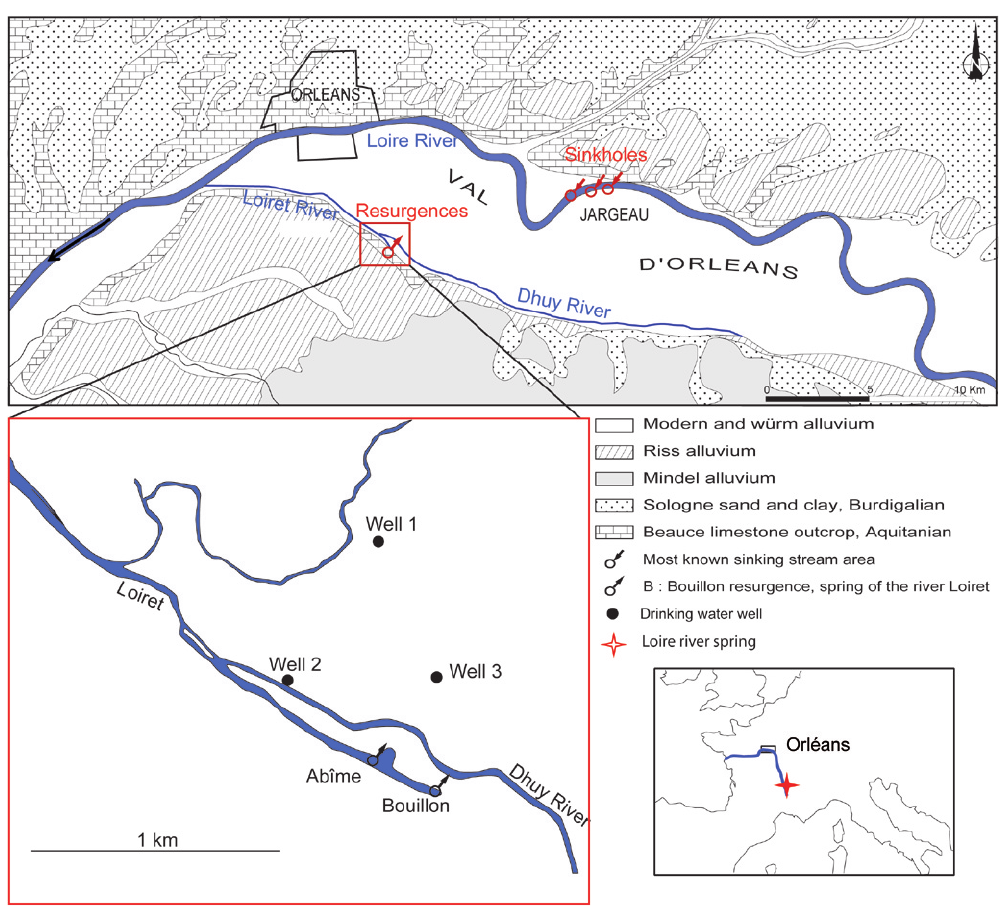
Fig. 1. Geological and hydrological setting of the study area (modified from Alb´eric, 2004). The Loire river, passing through the Val d’Orl´eans, loses water into sinkholes at Jargeau; the infiltrated surface water reaches several karst springs in the Loiret river. The Bouillon and Abˆıme springs are the major ones feeding the Loiret river. These resurgences can become sinkholes if the Dhuy river flows back into the Loiret river at the confluence, whereupon the infiltration of Dhuy waters into the aquifer can threaten the drinking water wells near the